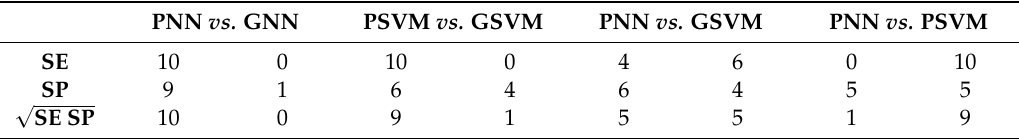
Table 5. Summary of the comparison with respect to SE, SP and a cell contains the number of subjects for whom the member of the pair is better for SE, SP or their geometric mean. PNN vs. GNN PSVM vs. GSVM PNN vs. GSVM PNN vs.